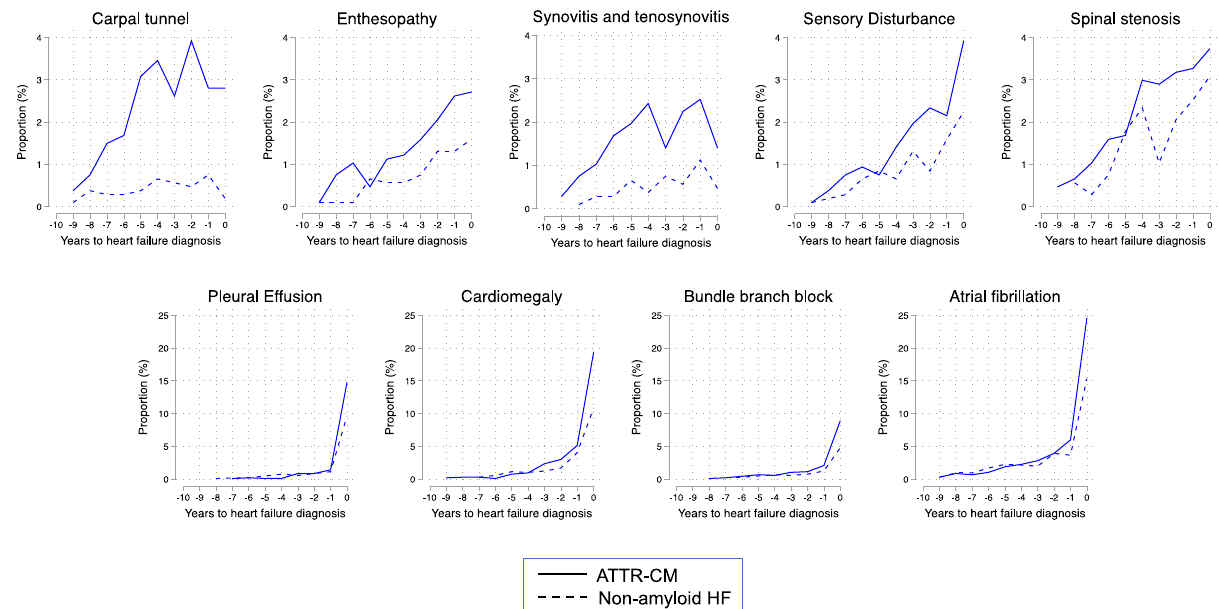
Fig. 3 Time course of non-cardiac and cardiac phenotypes associated with wild-type ATTR cardiomyopathy vs. non-amyloid heart failure prior to the diagnosis of heart failure. The proportion of patients at each time point (years before heart failure diagnosis) with a fi rst diagnosis of an associated feature (phenotype). The cumulative proportion of patients with each particular phenotype is equal to the sum of the proportions from each of the years preceding the heart failure diagnosis. ATTR-CM, amyloidogenic transthyretin